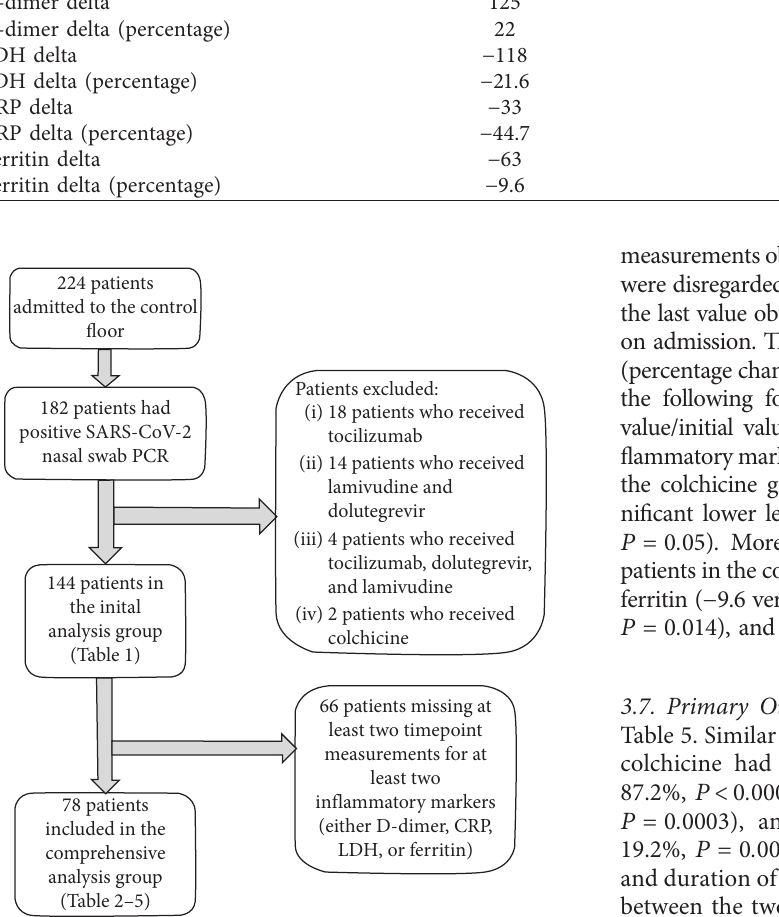
Figure 2: A flow diagram of the selection process for the patients in the control